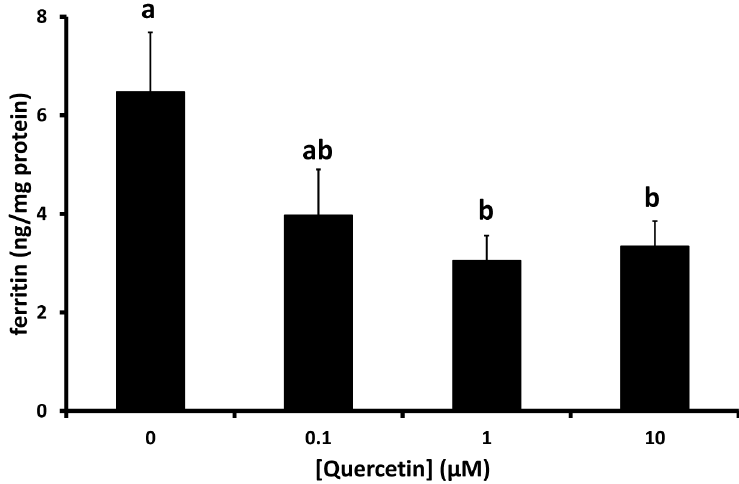
Figure 4. Effects of quercetin on ferritin protein levels in Caco-2 cells. Caco-2 cells were exposed to quercetin (10 or 100 m M) for 18 h. Cells were solubilised and aqueous extracts used to measured cell ferritin protein content using a commercially available ELISA. Data are mean 6 SEM of 15 observations in each group. Groups with no common letters are significantly different from each other (one-way ANOVA and Tukey’s post hoc test; P , 0.05).